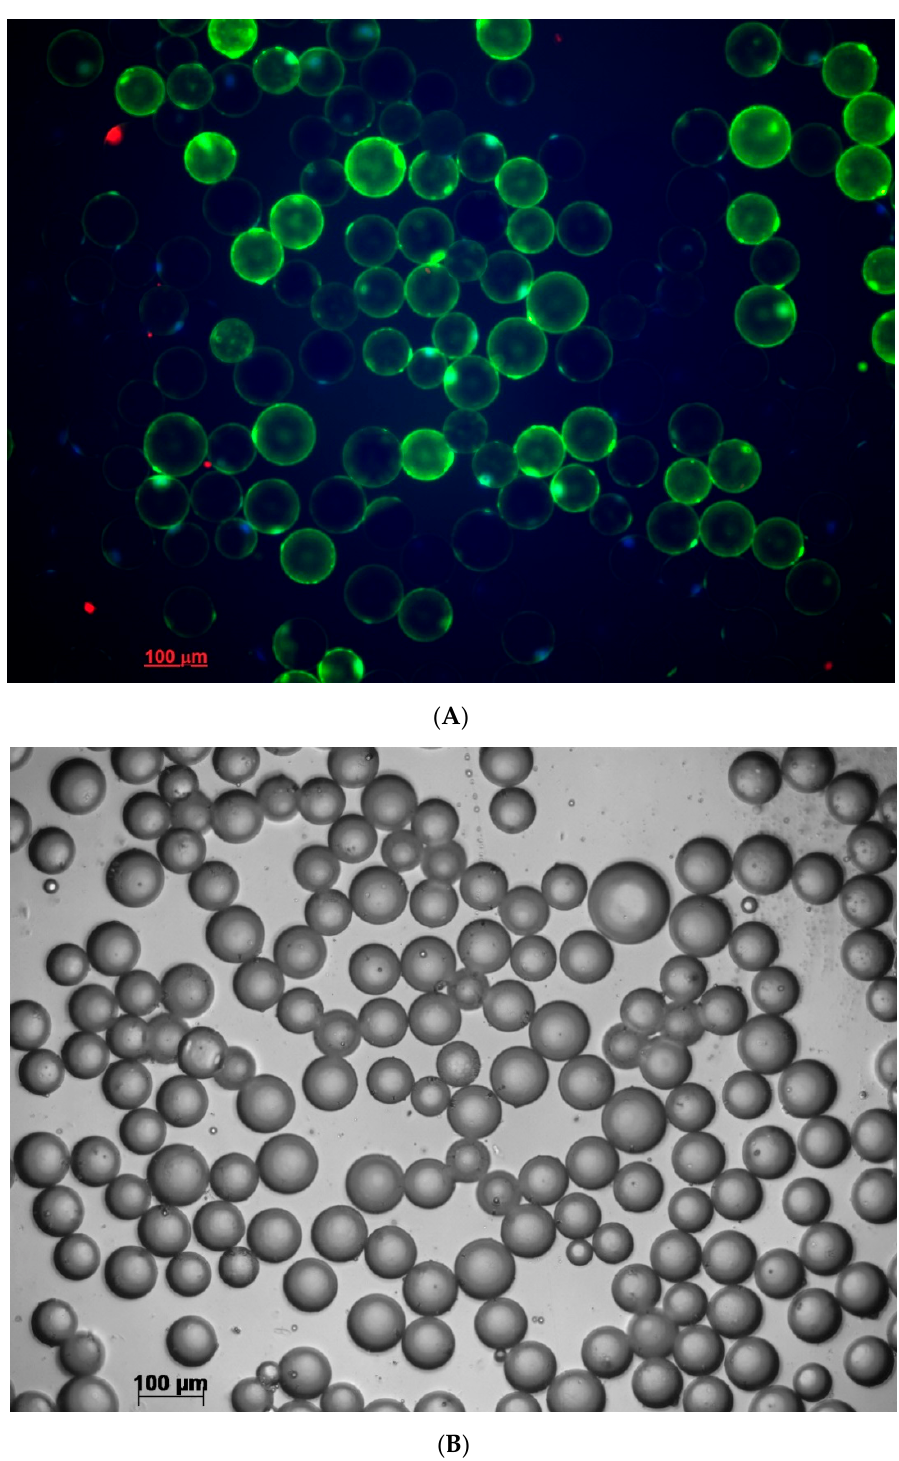
Figure 1. Accumulation of reactive oxygen species (ROS) and viability of adipocytes in epicardial adipose tissue (EAT) culture. ( A ) Fluorescence staining. Dyes: Green—2,3-dihydrodichlorofluorescein (ROS), red—Propidium iodid (dead cells), blue—Hoechst 33,342 (viable cells). ( B ) Corresponding light microscopy of EAT adipocytes. Magnification × 200. EAT, epicardial adipose